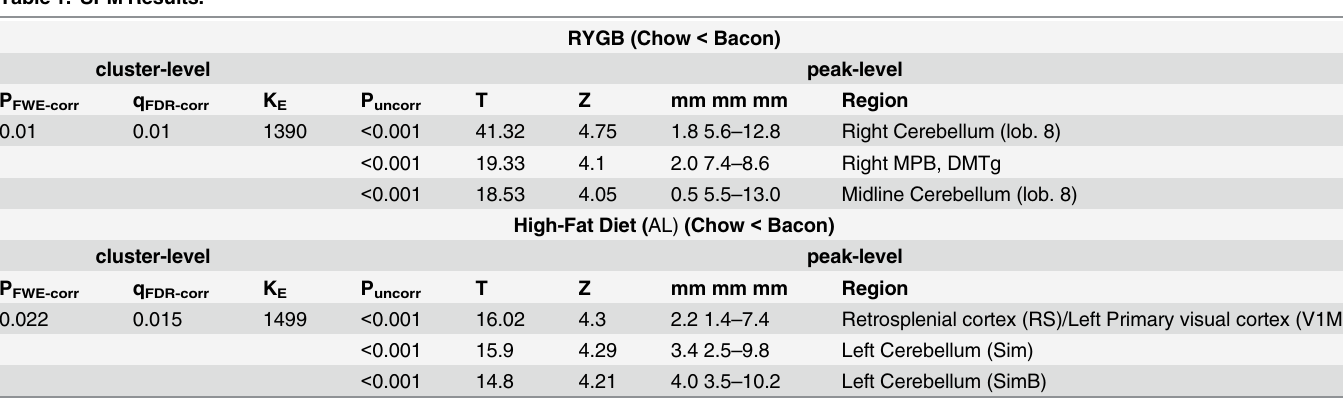
durability of the reported RYGB-related changes in food selection show significant inconsisten- cies [40], and pre-surgical exposure to fat may also influence post-operative food preferences [41]. RYGB may affect both taste preferences and actual preferential intake of different macronu- trients, and it is important to distinguish between an increase in liking or disliking a taste de- spite the absence in increases in intake, due to the restrictive nature of the RYGB [42]. In obese rats, RYGB alleviates obesity-related alterations in taste function, namely shifting preference from high to lower fat concentrations. RYGB animals also change their responses to fatty food; and show a preference for a diet with low rather than with high-fat content [25]. Moreover the sensitivity to the rewarding properties of HF foods was reduced after RYGB [24,25].